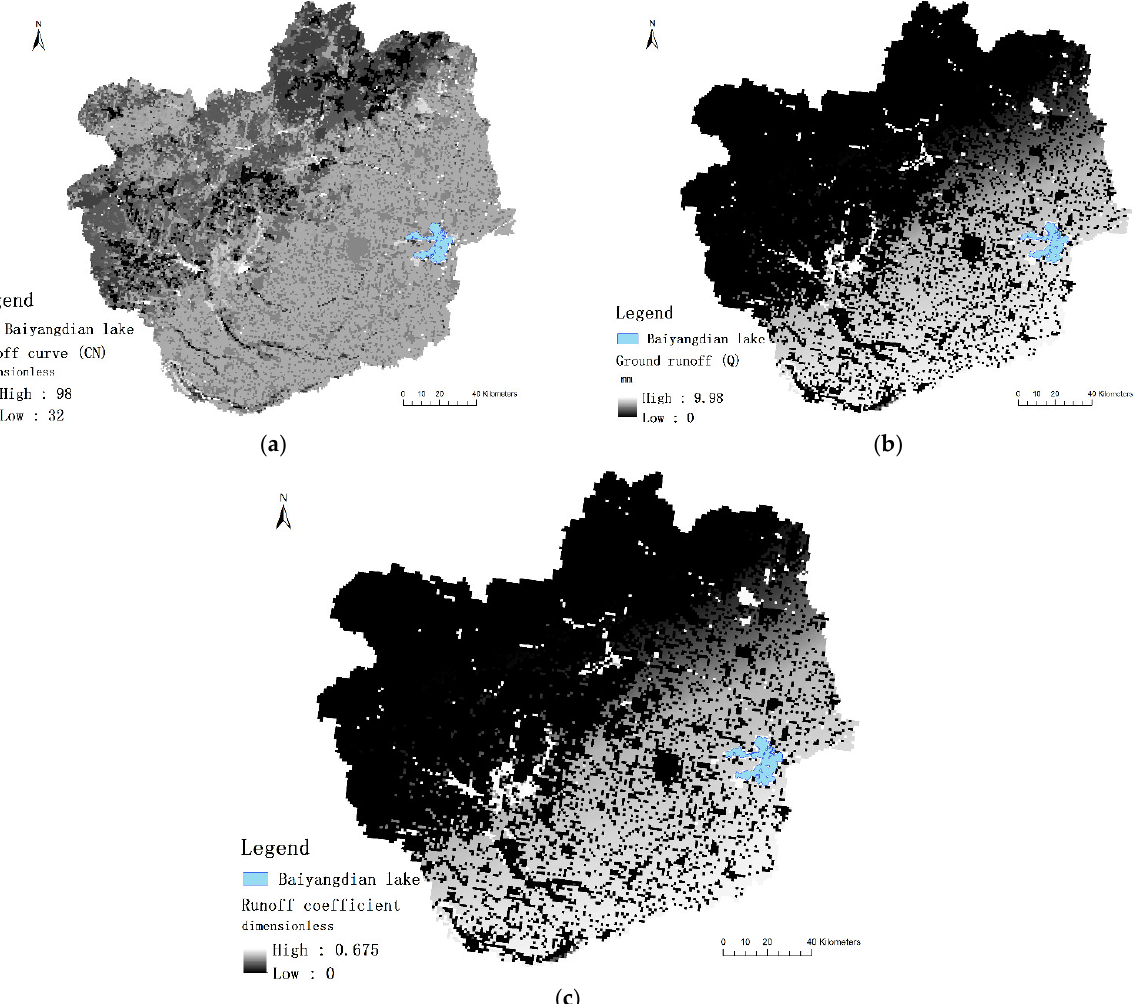
Figure 4. Coefficient parameters of rainfall in the study area: ( a ) Runoff curves (CN), ( b ) Ground runoff (Q), ( c ) Runoff coefficient.